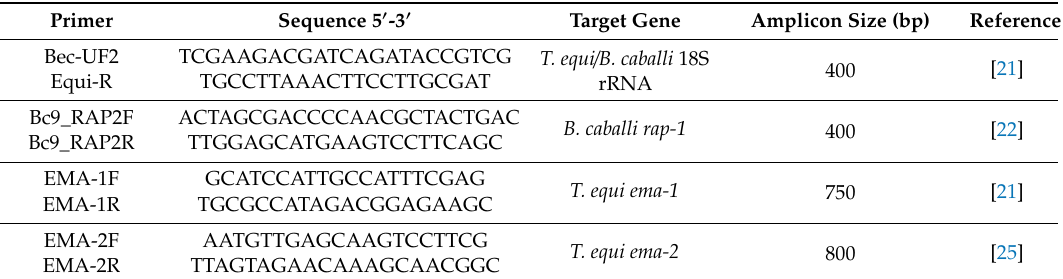
Table 1. The polymerase chain reaction (PCR) primers used in this